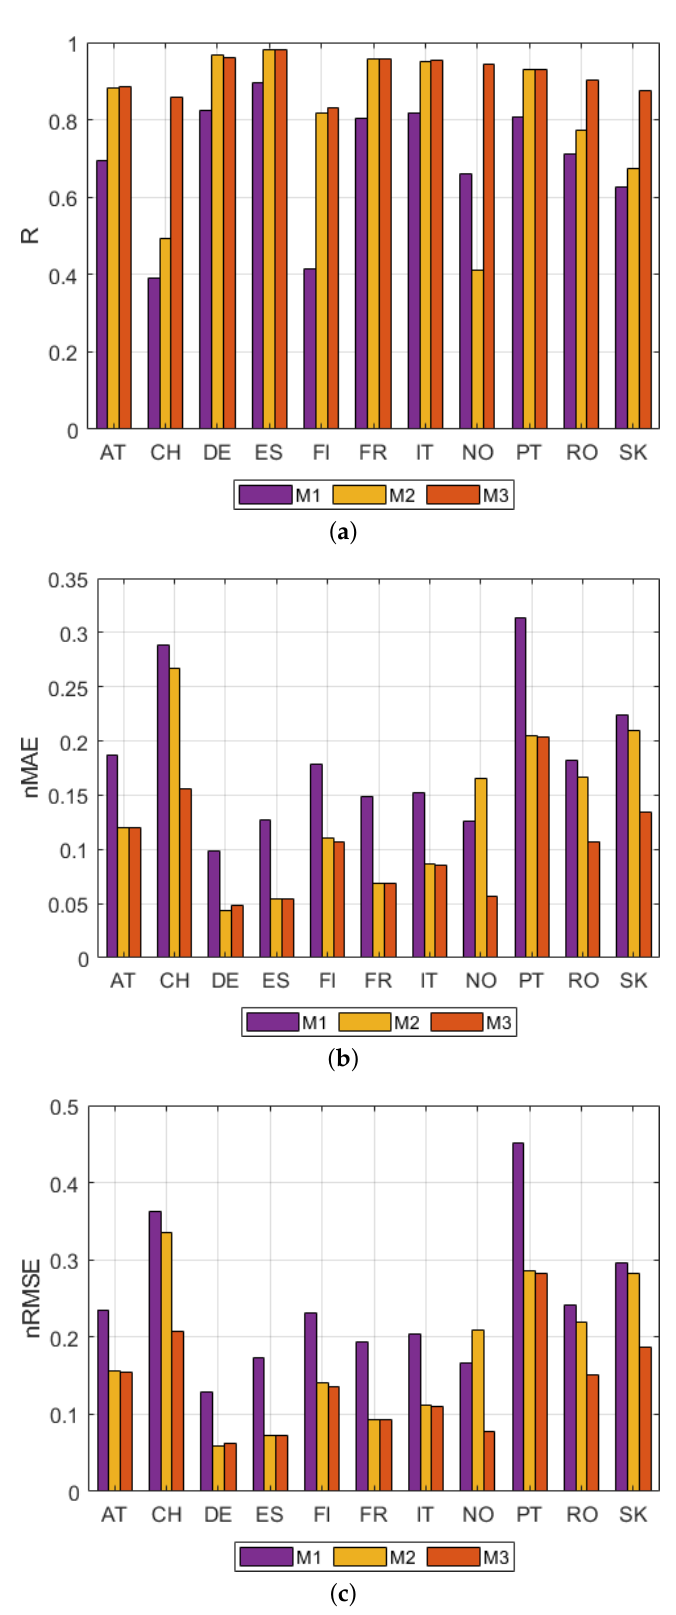
Figure 3. Models comparison via 5-fold cross-validation: ( a ) correlation coefficient, ( b ) normalized mean absolute error, and ( c ) normalized root mean square